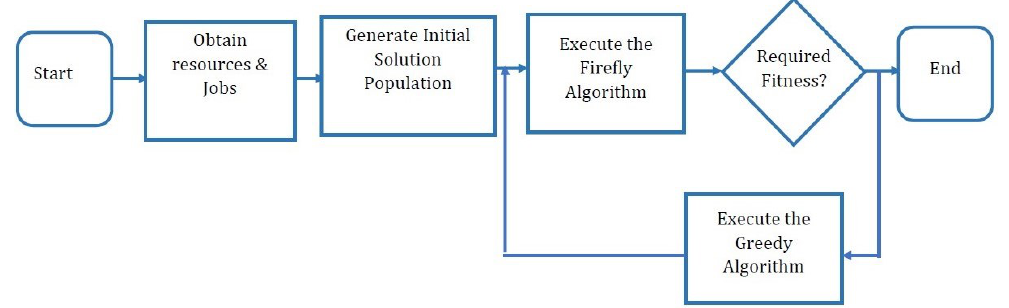
Figure 4. The Flowchart of the Proposed